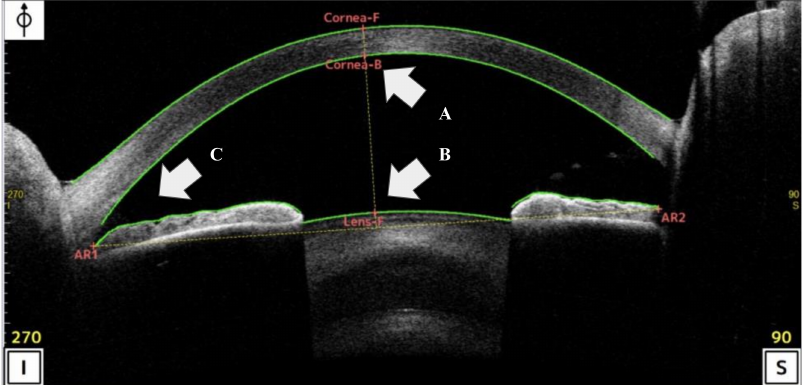
Figure 2. Scan of the analysis interface in anterior-segment optical coherence tomography (AS-OCT) (CASIA2 Advance system: Tomey, Nagoya, Japan). ( A , B ) Anterior chamber depth (ACD) was define the distance between the apex of the posterior corneal to apex of the crystalline lens using AS-OCT. ( C ) Trabecular-iris angle (TIA) was measured with the apex in the iris angle recess and the arms of the angle passing through a point on the trabecular meshwork 500 µ m from the SS and the point on the